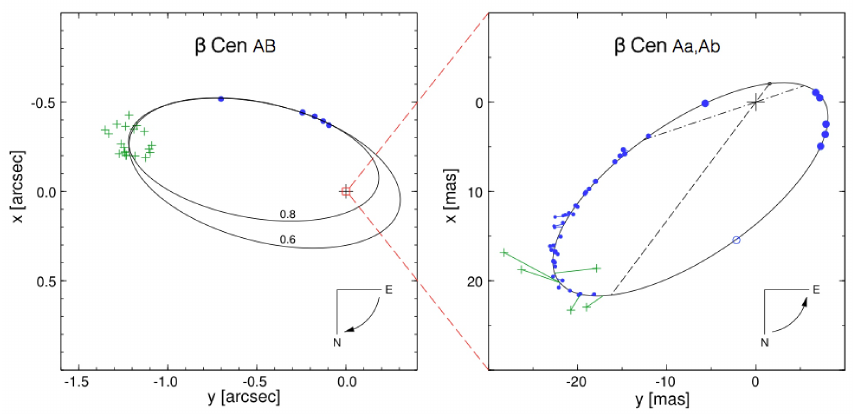
Figure 17. The triple system β Centauri, with two example orbits (excentricity of 0.6 and 0.8). Adapted from Figures 1 and 2 of Pigulski et al.